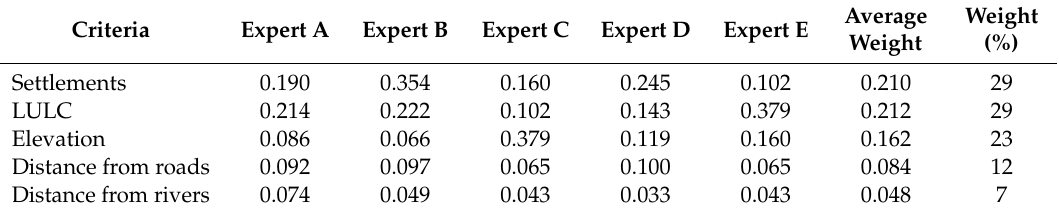
Table 9. Expert opinion weights for prioritizing the criteria in